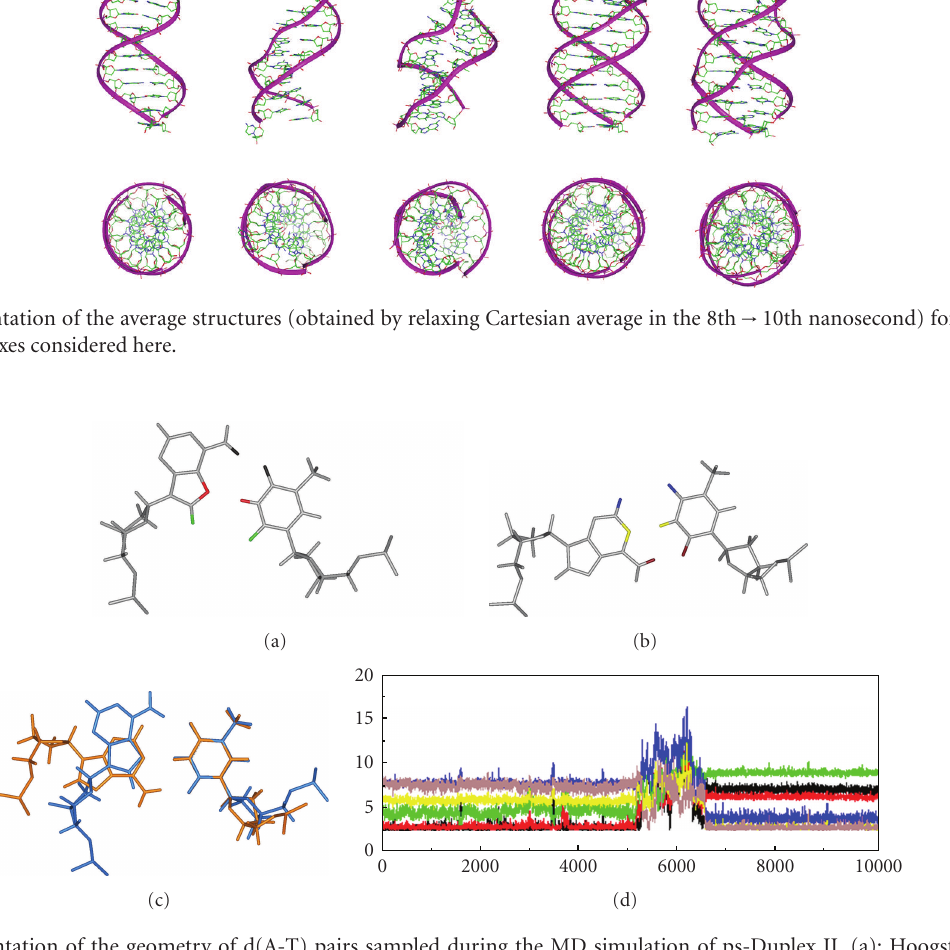
Figure 7: Representation of the geometry of d(A-T) pairs sampled during the MD simulation of ps-Duplex II. (a): Hoogsteen pair. (b): reverse-Watson-Crick. (c): superposition of both Hoogsteen and reverse-Watson Crick pairings. (d) detail of hydrogen bond distances in one of the pairs showing Hoogsteen → reverse Watson-Crick transitions. Color code: (i) Hoogsteen; Black: H6-O4; Red: N7-H3; Green: H8-O2; and (ii) reverse WC; Blue: H2-O4; Yellow: N1-H3; Light brown: H6-O2.